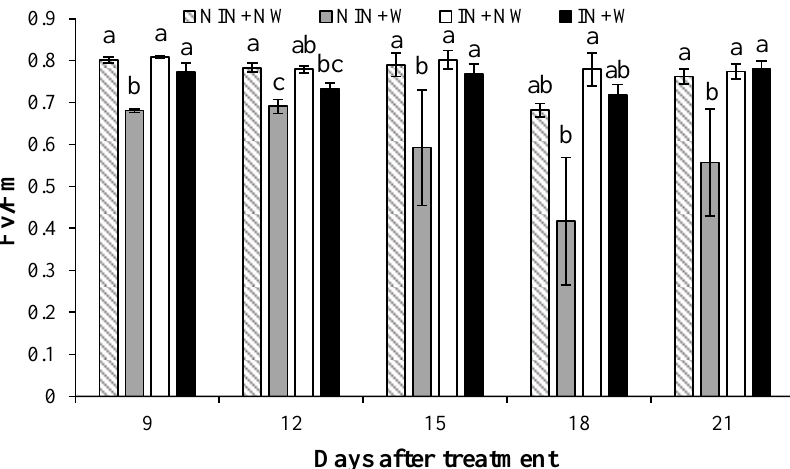
Figure 3. Maximum efficiency of PSII in R. sativus under waterlogged conditions and inoculated with A. brasilense . Averages followed by different letters at each sampling point show statistical differences according to Tukey’s test ( p < 0.05). Vertical bars in each average indicate standard error ( n = 11).